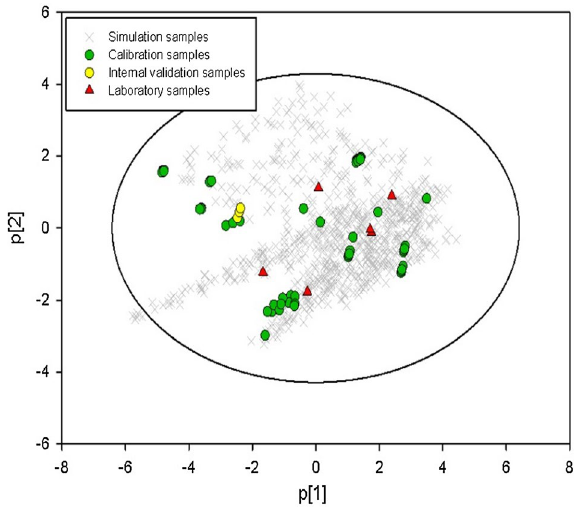
Figure 4. The LV1 vs LV 2 score scatter plot of PLS model